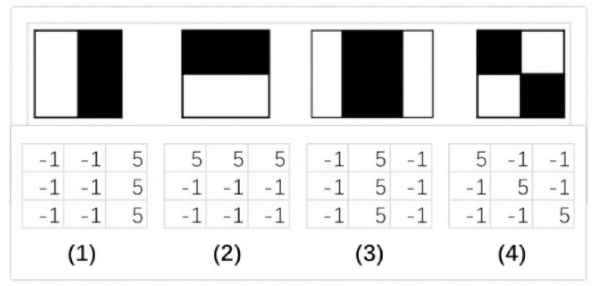
Fig 2. Haar algorithm features with kernel window